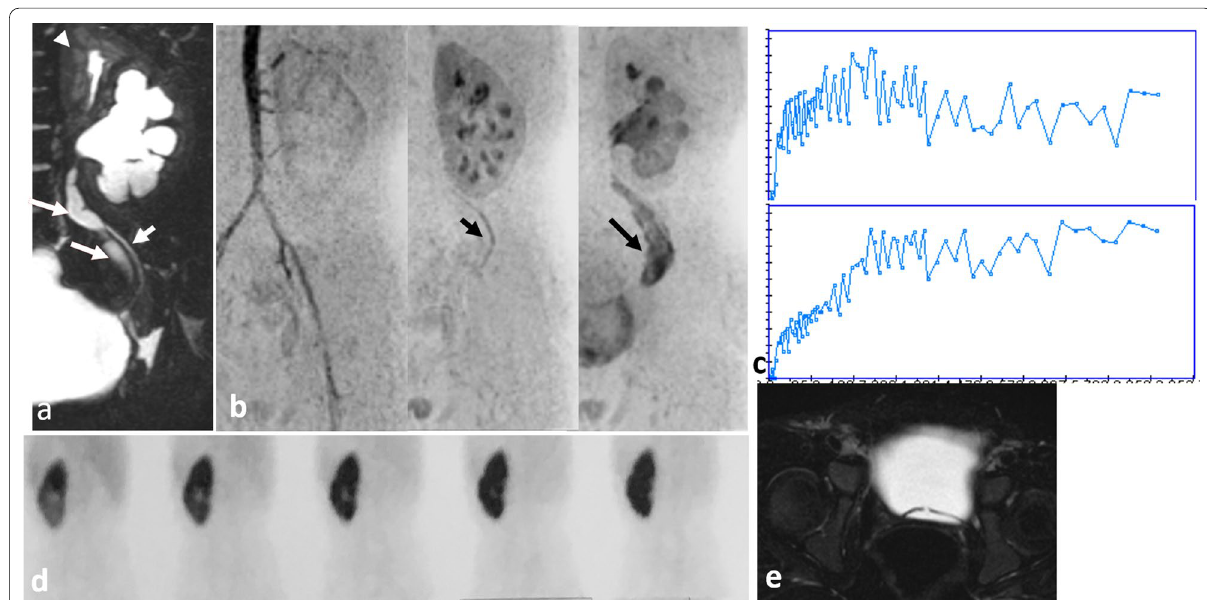
Fig. 6 2-year-old boy with history of recurrent UTI with history of right nephrectomy and left renal duplex system and ureterocele underwent incision. a Coronal MRU reveals preserved parenchyma of the upper moiety (arrowhead) and P3 UTD the lower moiety (associated with ureteric dilatation (long arrows). Note relative parenchymal thinning of the lower moiety compared to the upper one. The ureter of the upper moiety is not dilated (short arrow). b Dynamic MRU reveals a multiple blood vessels rather than single renal artery supplying the left kidney; normal excretory function of the upper moiety with earlier appearance of the right ureter (short arrow); relatively mild delay in contrast excretion into the ureter of the lower moiety (long arrow). RTT of the upper pole 171, lower pole 251 s. c Time intensity curve of the upper moiety shows normal drainage = = (upper curve), while there is plateau curve of the lower moiety (lower curve). d DTPA dynamic renal scintigraphy shows early photopenic area at the region of the lower moiety which fills up with tracer. e Axial MRU shows the incised